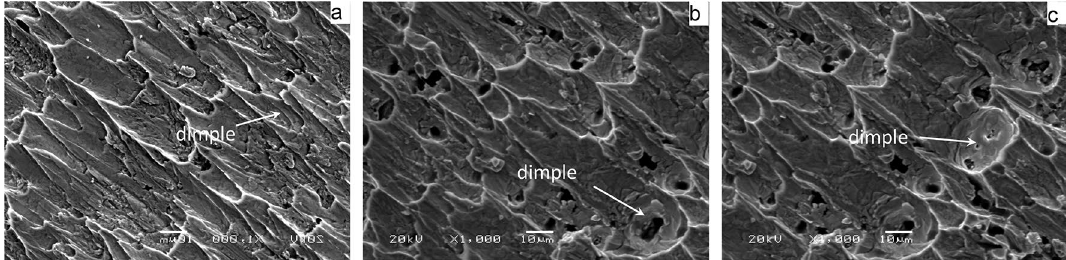
Figure 14. Shear-fractured morphology of solder joints after 500 thermal cycles ( a ) 0Ni, ( b ) 0.05Ni, ( c ) 0.1Ni.